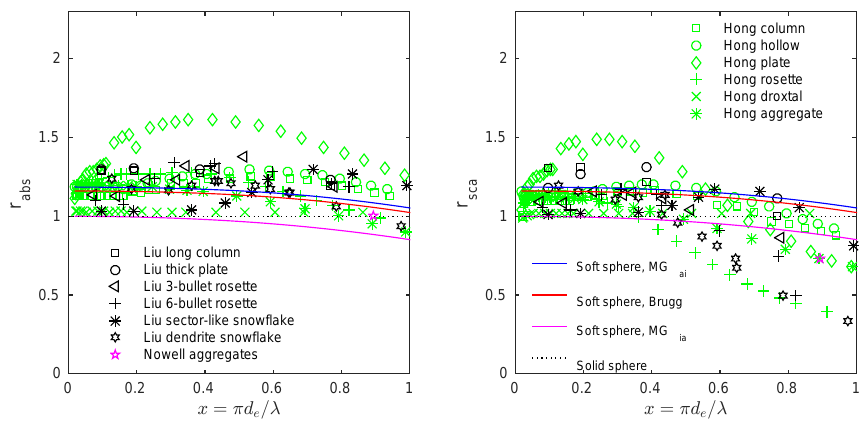
Figure 4. Absorption (left) and scattering (right) cross sections of DDA data and soft spheres at 183GHz. The cross sections are reported as the ratio to the corresponding cross section of the equivalent mass sphere, with the same refractive index as used for the preparation of the DDA data. That is, the dotted straight line at r = 1 represents solid ice spheres. Database source and particle shapes of the DDA data are found in figure legends (same as in Fig. 3). The soft spheres have an air fraction of 0.25, where results for three different mixing rules (MG ia , Bruggeman and MG ia ) are included (solid